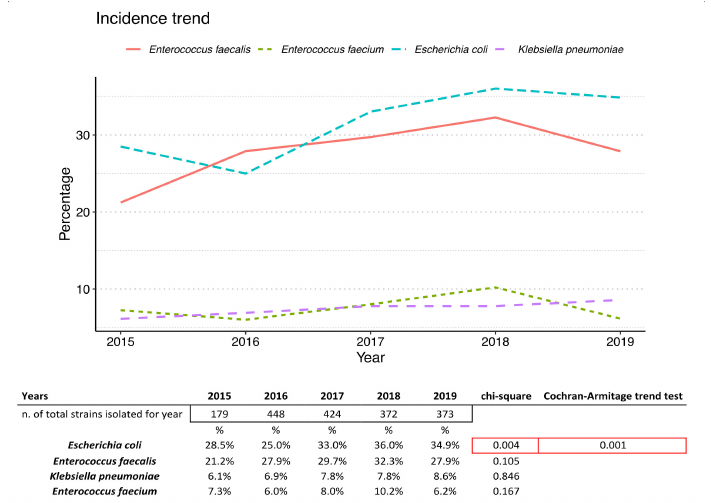
Figure 2. Incidence trend of the main representative bacteria isolated during the 5 years